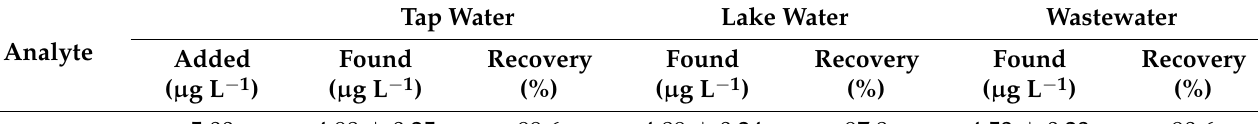
Table 2. Determination of estrogens in water samples (95% confidence interval; n =